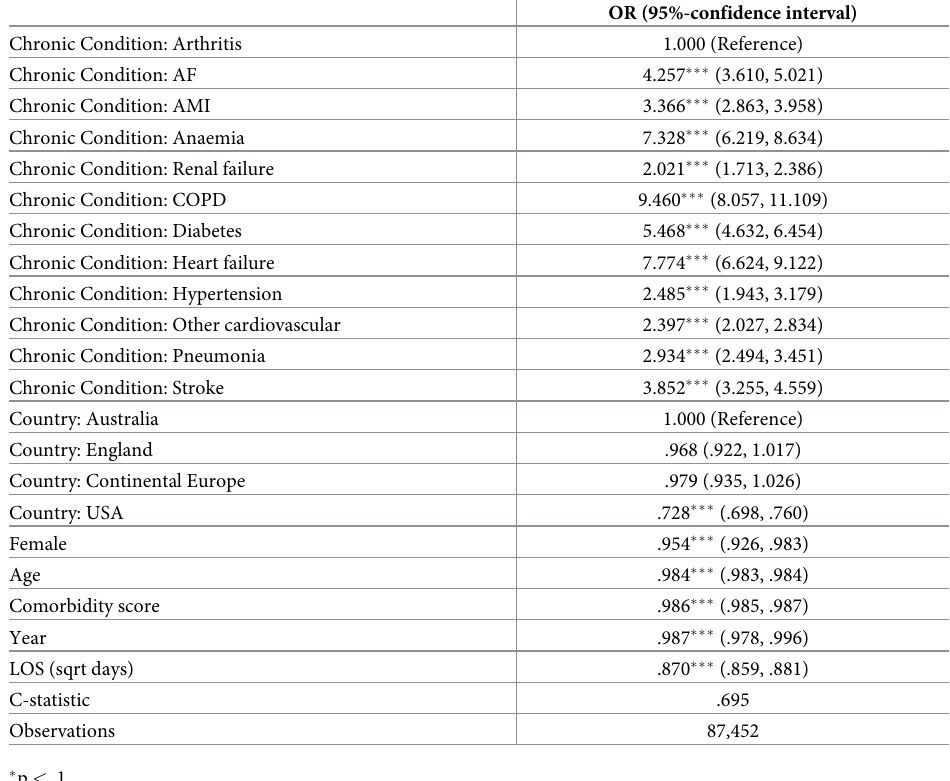
OR (95%-confidence interval)